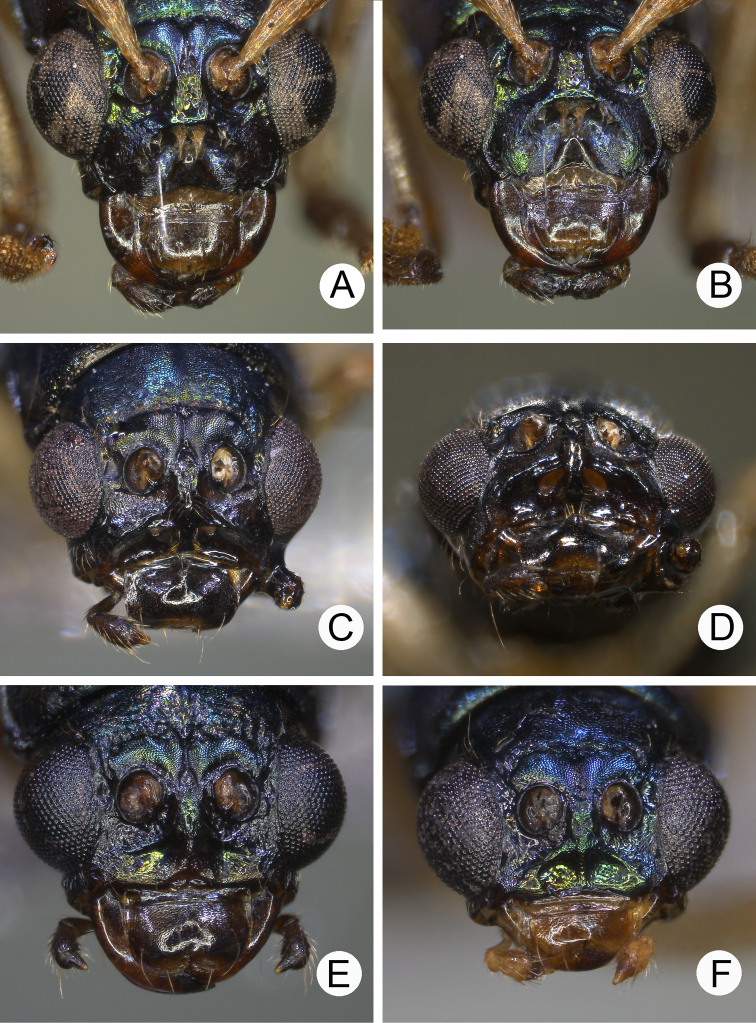
Heads of Pseudotheopea
kimotoi sp. nov., P.
sufangae sp. nov., and P.
sauteri. AP.
kimotoi sp. nov., male, dorsofrontal view B Same, front view CP.
sufangae sp. nov., male, dorsofrontal view D Same, front view EP.
sufangae sp. nov., female, dorsofrontal view FP.
sauteri, female, dorsofrontal view.